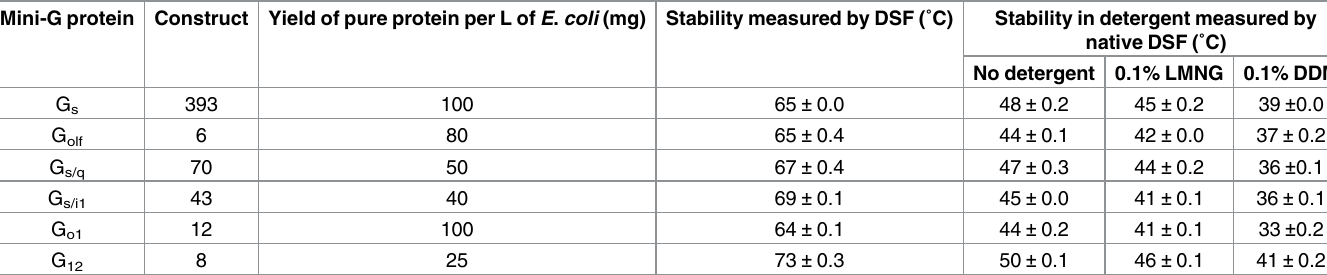
Table 1. Mini-G proteins and their characteristics. Mini-G protein Construct Yield of pure protein per L of E . coli (mg) Stability measured by DSF (˚C) Stability in detergent measured by